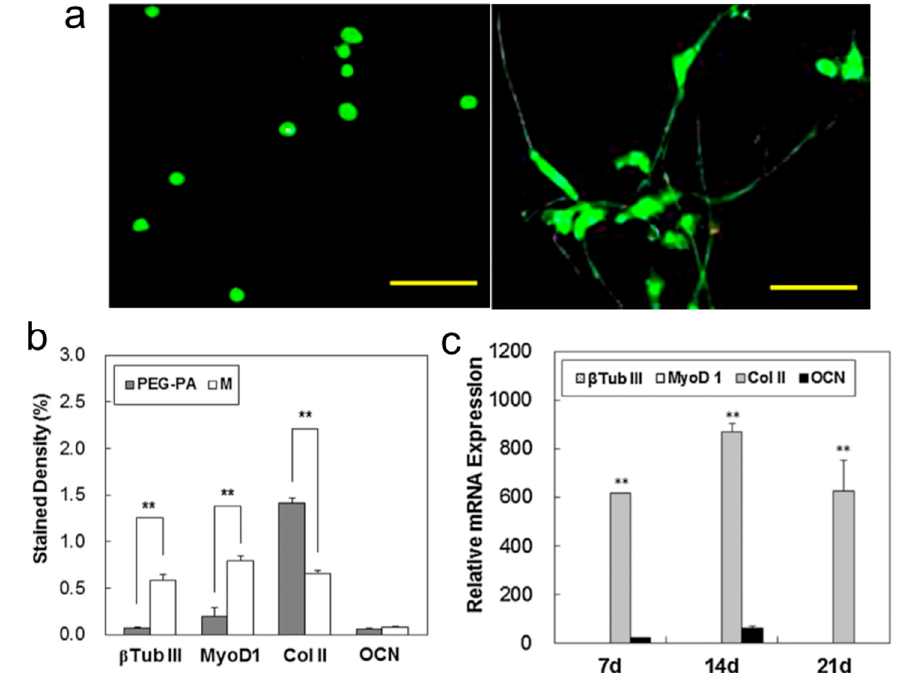
Figure 9. ( a ) Morphology of cells in the PEG-PA thermogel (left) and Matrigel TM (right) at the 21st day. The scale bar is 40 μ m; ( b ). Immunofluorescent assay using Image J software, ** indicates p < 0.05 Student t -test; ( c ) Gene expression in vivo of the BMSCs, ** indicates p < 0.05 by Student t -test (reproduced with permission from [44]).